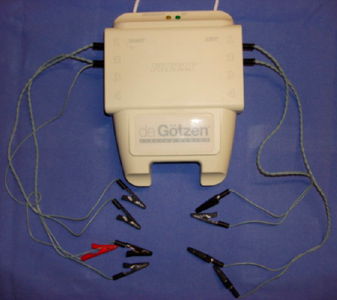
Figure 2. Freely electromyograph (De Gotzen, Legnano, Italy).